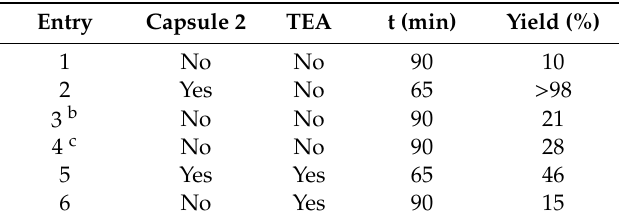
Table 4. Catalytic tests for the sulfoxidation of dibutyl sulfide with 30% H 2 O 2 a . Entry Capsule 2 TEA t (min) Yield